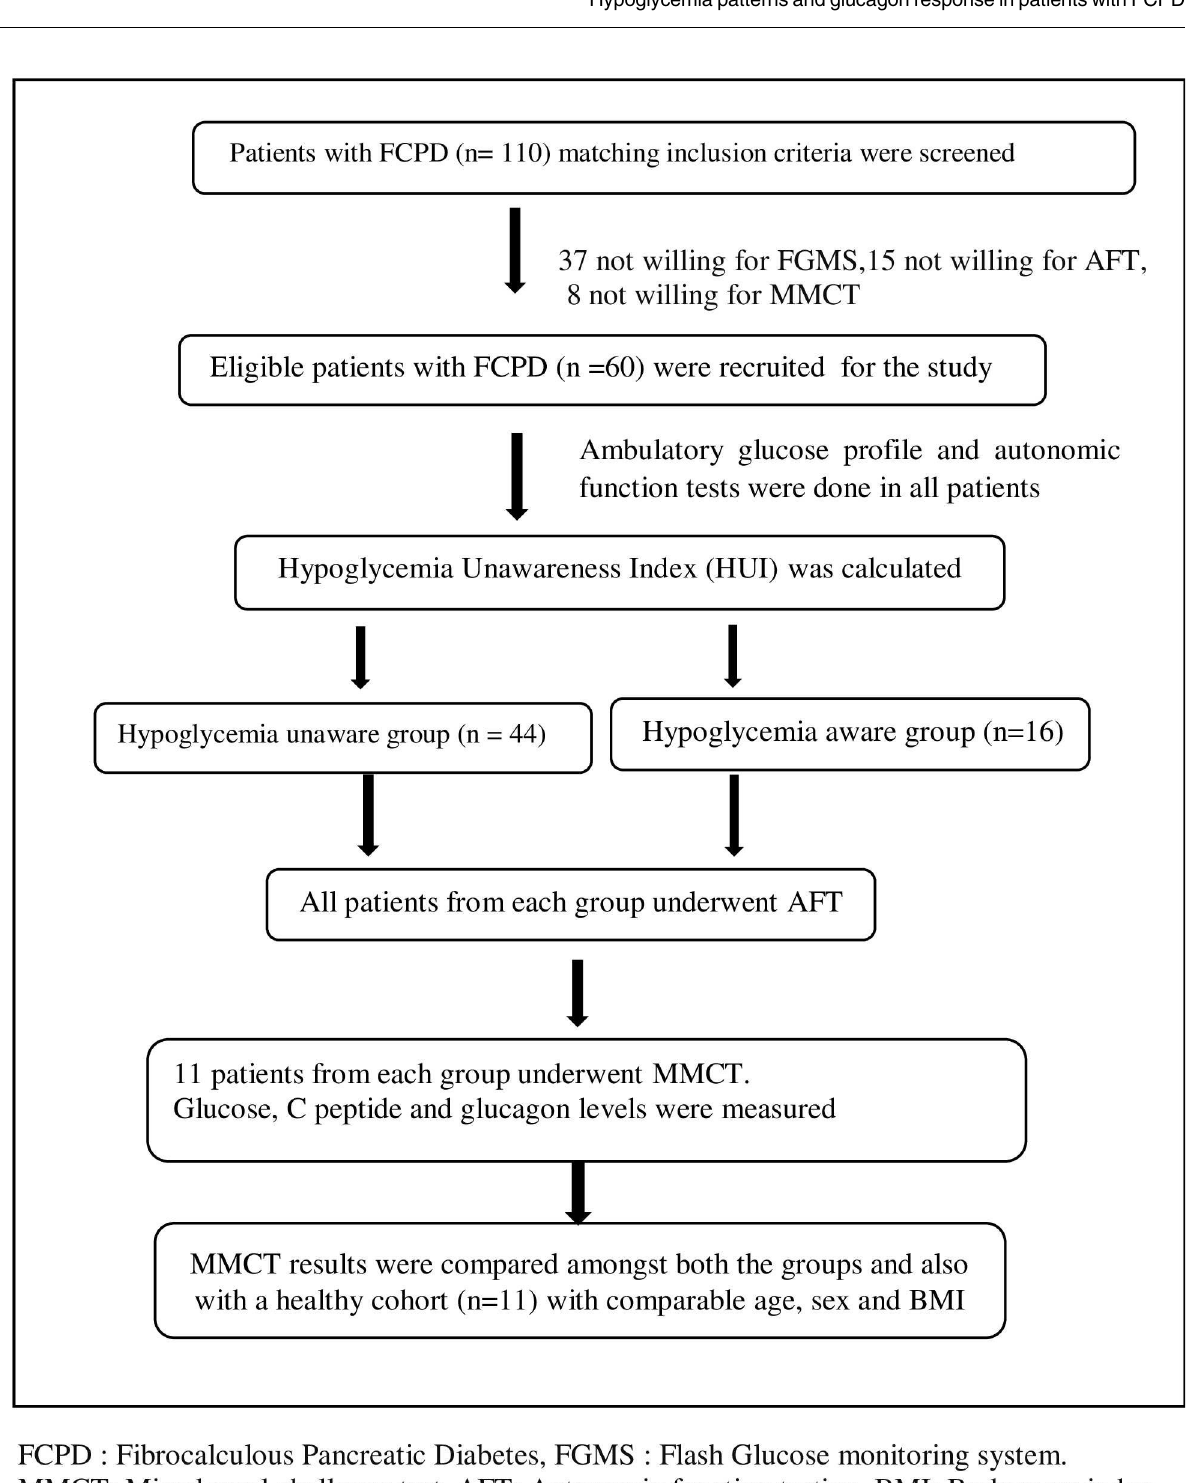
Fig 1. Algorithm of the